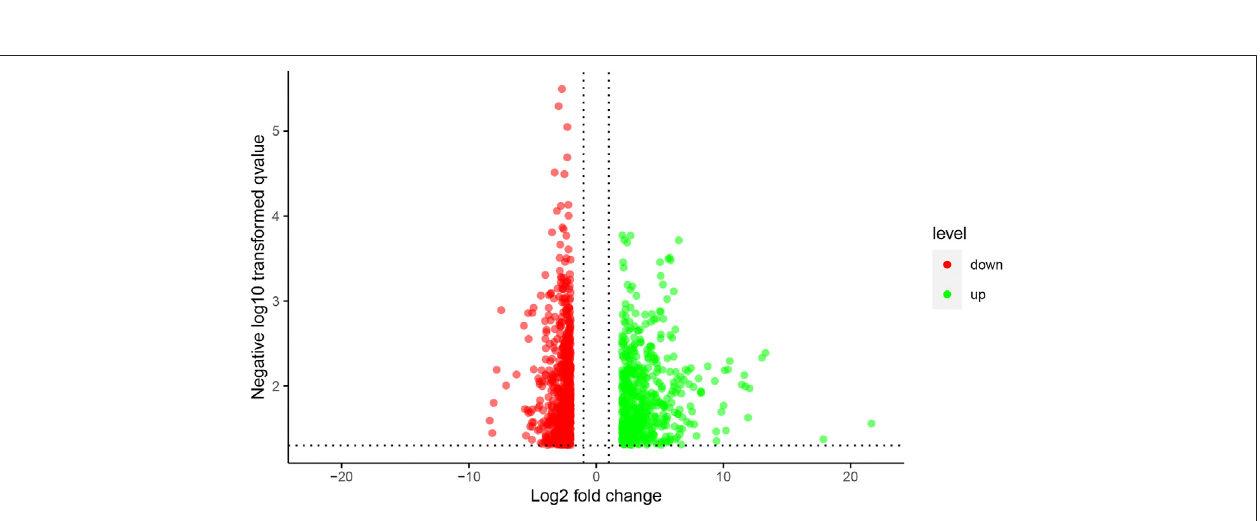
Frontiers in Pharmacology |